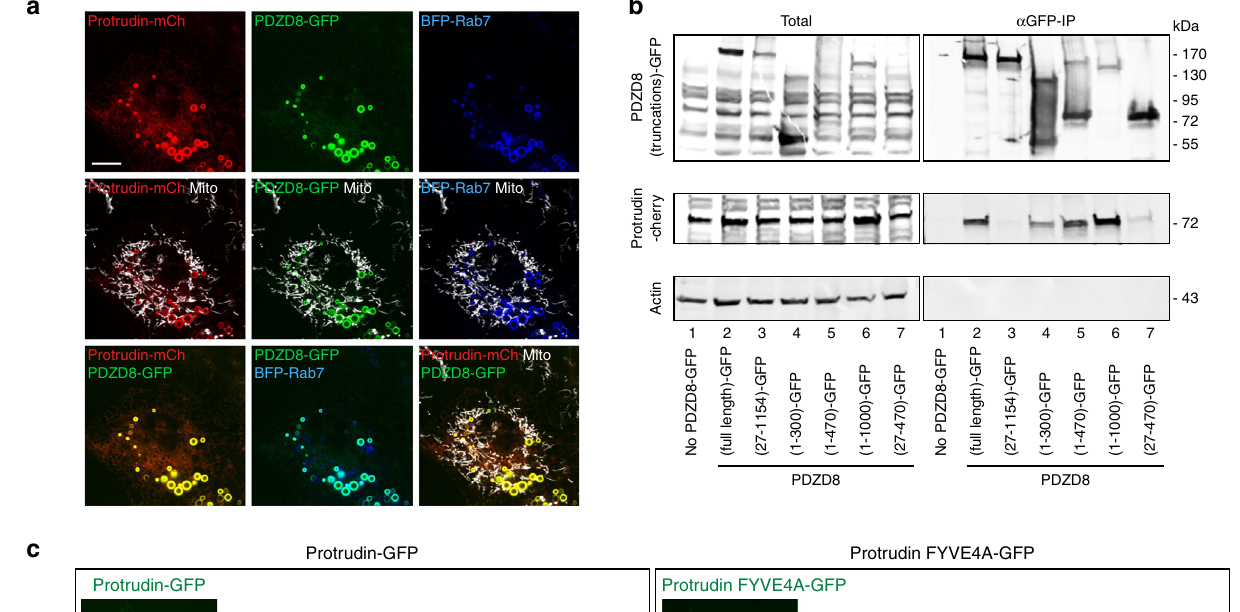
MergeMerge Merge Merge PDZD8 Δ CC-mCh Merge Merge Merge Merge PDZD8 Δ CC-mCh Fig. 4 PDZD8 and Protrudin associate independently with late endosomes. a PDZD8-GFP co-localizes with Protrudin-mCherry on BFP-Rab7-labeled late endosomes. Representative image of a U2OS cell co-expressing PDZD8-GFP, BFP-Rab7, and Protrudin-mCherry. Mitochondria were labeled with MitoTracker DeepRed. Scale bar: 10 μ m. b The PDZD8 TM domain is required for its interaction with Protrudin. Extracts from HEK293T cells expressing various GFP-tagged truncated versions of PDZD8 (as illustrated in Fig. 3a) and Protrudin-mCherry were immunoprecipitated with GFP-Trap beads and western blot analysis was performed using anti-GFP, anti-Actin anti-Protrudin antibodies for detection of PDZD8-GFP truncated versions, actin and Protrudin, respectively. Source data are provided as a Source Data fi le. c PDZD8-GFP and Protrudin-mCherry are independently recruited to BFP-Rab7- labeled endosomes. Representative images of PDZD8 KO HeLa cells expressing either wildtype Protrudin-GFP or Protrudin FYVE4A-GFP and co- expressing BFP-Rab7 with either PDZD8-mCherry or PDZD8 Δ CC-mCherry. Scale bar: 10 μ endosomes. However, in PDZD8 KO cells expressing BFP-Rab7 endosomes required the PDZD8 CC region, consistent with our and PDZD8-mCherry, Protrudin-FYVE4A-GFP co-localized to data indicating a role for CC domain in the recruitment of Rab7-endosomes (Fig. 4c, compare right top two panels with PDZD8 to late endosomes (Figs. 3b and 4c, compare right top right ( + PDZD8 + Rab7) panel). This PDZD8-dependent mode two panels with right ( + PDZD8 Δ CC + Rab7) panel). We also of Protrudin-FYVE4A-GFP recruitment to BFP-Rab7-labeled observed that Protrudin-GFP was not as ef fi ciently recruited to